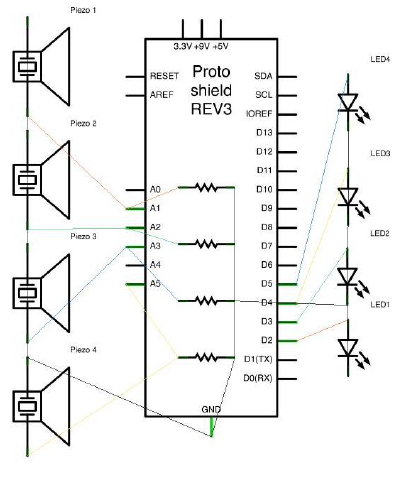
Figure 3. Schematics of the custom Arduino board built for the wired